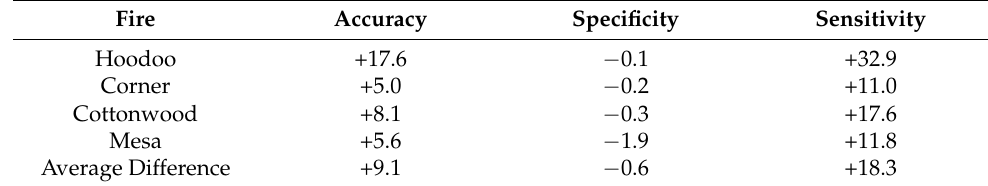
Table 8. Improved Accuracy Using Unburned Tree Noise and Sub-Crown Burn